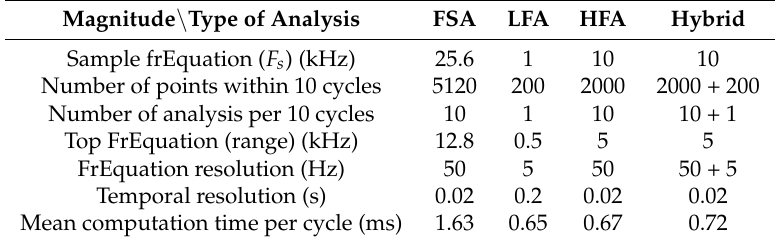
Table 1. Strategies for the measurement method (100 signals under test). The full option accounts for the total surveillance. The + sign indicates the options for the complementary HFM. Magnitude \ Type of Analysis FSA LFA HFA Hybrid Sample frEquation ( F s )